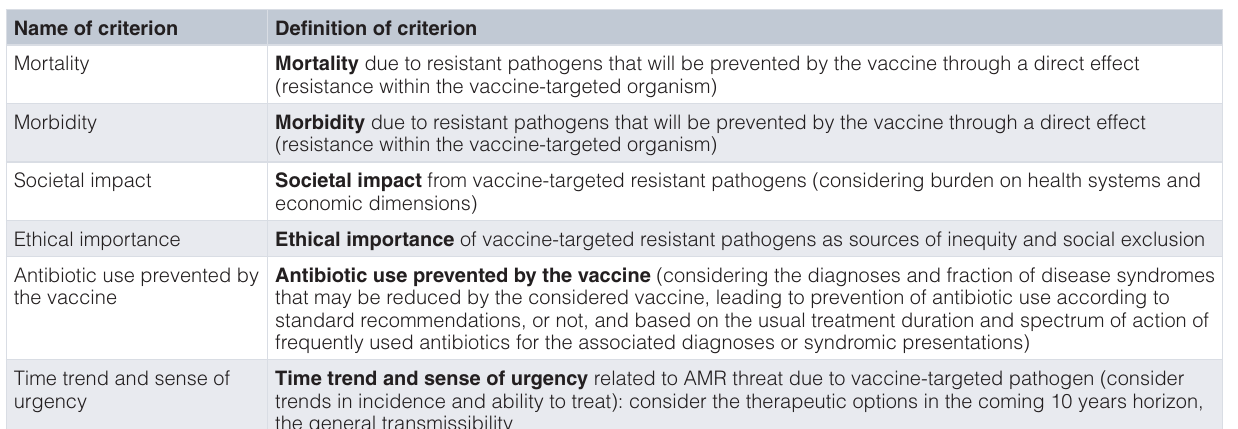
Table 2. Evaluation